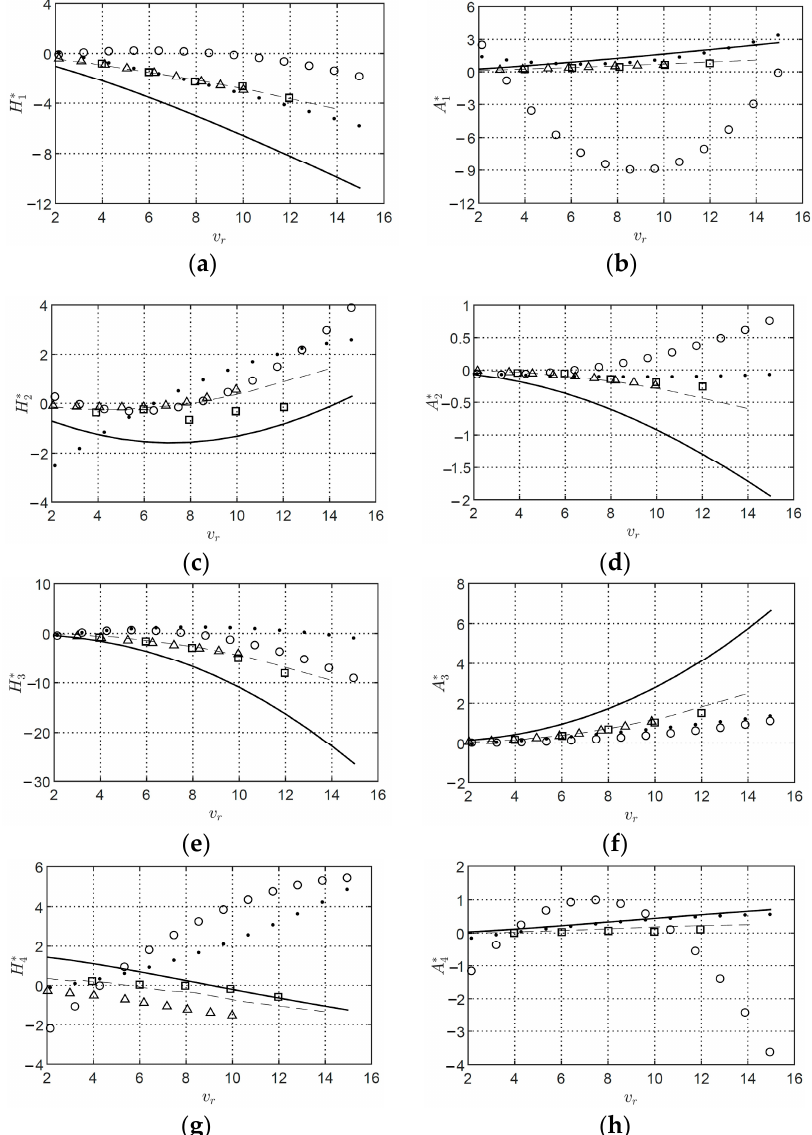
Figure 28. Comparison of aerodynamics derivatives from 2DOF test for Setup 1. (o) Polynomial fit from pitch using ILS method, (…) polynomial fit from heave using ILS method, ( □ ) wind tunnel test [42], ( ∆ ) wind tunnel test [2], ( ‒ ‒ ) water channel tests, ( ― ) fl at plate by Theodorsen. ( a ) 𝐻 (cid:2869)∗ ; ( b ) 𝐴 (cid:2869)∗ ; ( c ) 𝐻 (cid:2870)∗ ; ( d ) 𝐴 (cid:2870)∗ ; ( e ) 𝐻 (cid:2871)∗ ; ( f ) 𝐴 (cid:2871)∗ ; ( g ) 𝐻 (cid:2872)∗ ; ( h ) 𝐴 (cid:2872)∗ . Table 5. Mechanical system matrices for wind-off conditions from the ILS method .